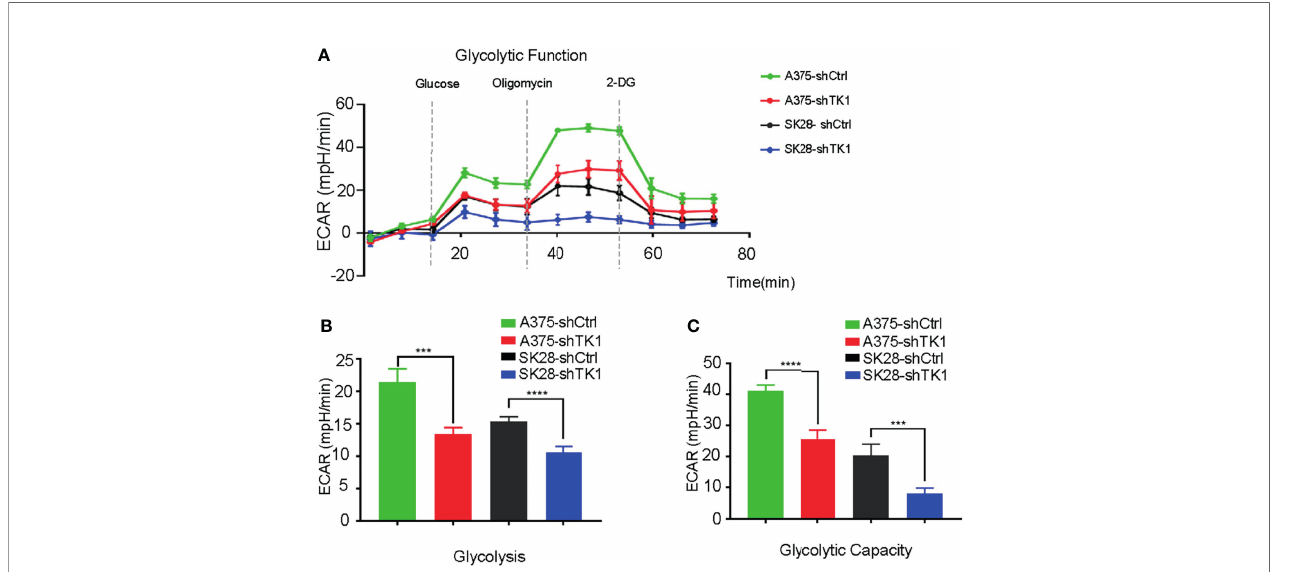
FIGURE 6 | The extracellular acidi fi cation rate (ECAR) was suppressed in thymidine kinase 1 (TK1) knockdown group. (A) The glycolytic function curve of control group and TK1 downregulation group. (B, C) The glycolysis and glycolytic capacity were inhibited in TK1 knockdown group. ***p < 0.001, ****p <